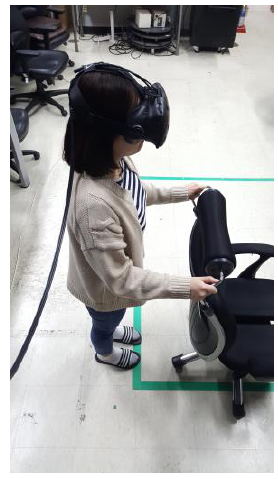
Figure 15. When performing WIP, a user could grab or lean on something to maintain balance. A subject preparing to complete a task. Using a chair with handles, the subject maintains balance. The chair is fixed so it cannot be